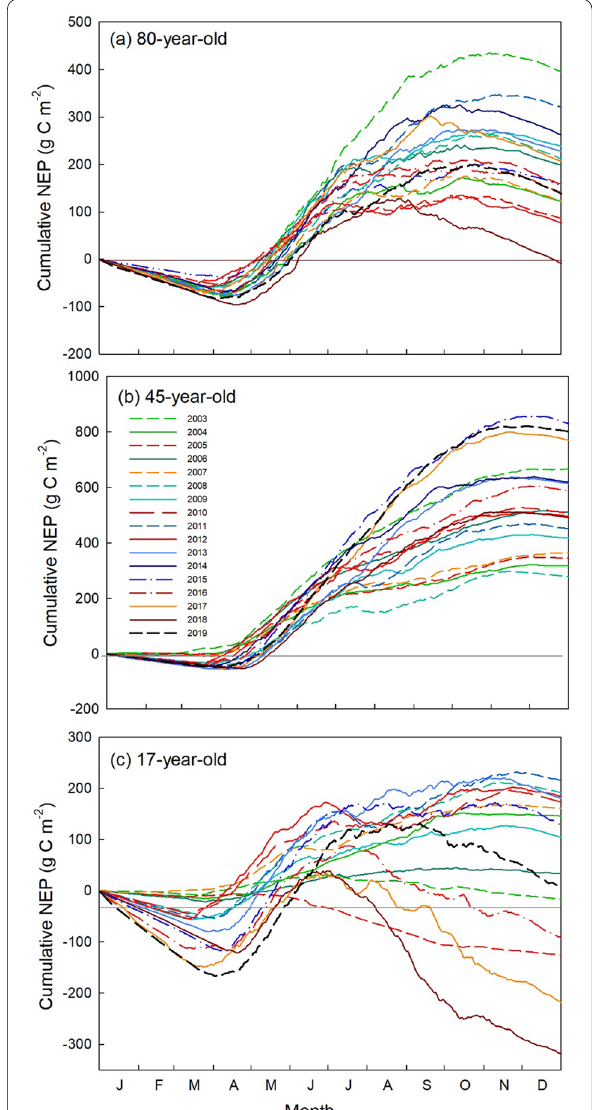
Fig. 2 Cumulative annual net ecosystem productivity (NEP) at the a 80‑year‑old, b 45‑year‑old, and c 17‑year‑old forests. Dry years are shown as yellow (2007, 2017), hot year as burgundy (2018), and concurrent hot and dry years as red (2005, 2010, 2012 and 2016) shades of coloured